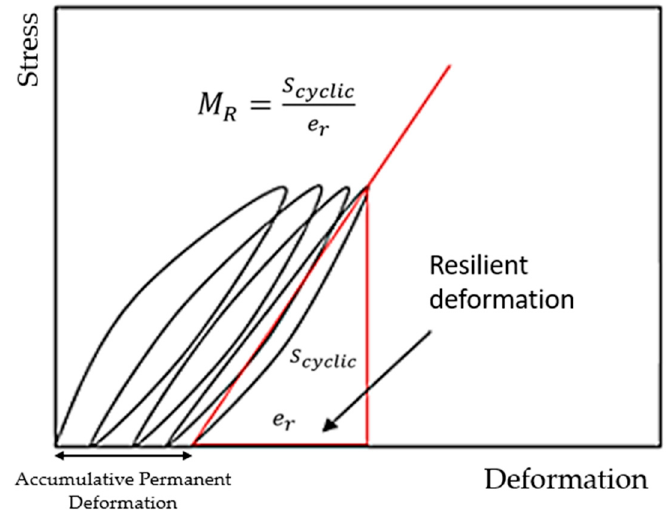
Figure 3. Mechanical behavior of granular material under triaxial testing [50].